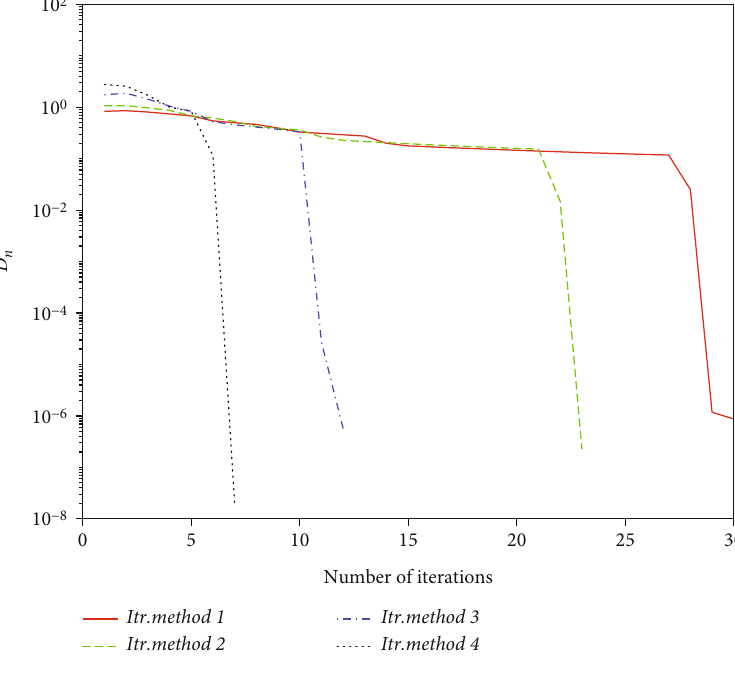
= ð 1, 3, 5, 4, 7 Þ T 0